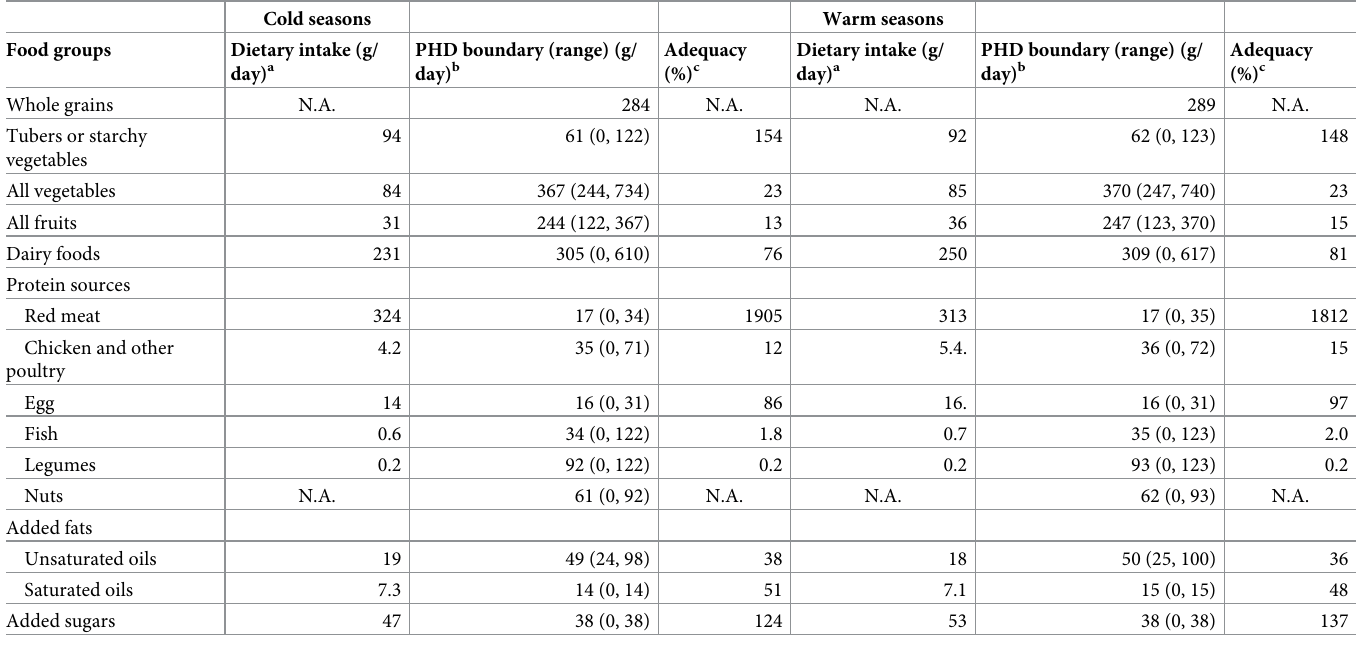
Table 4. Mongolian dietary intake compared with the health boundary of the planetary health diet and the adequacy during the two seasons.